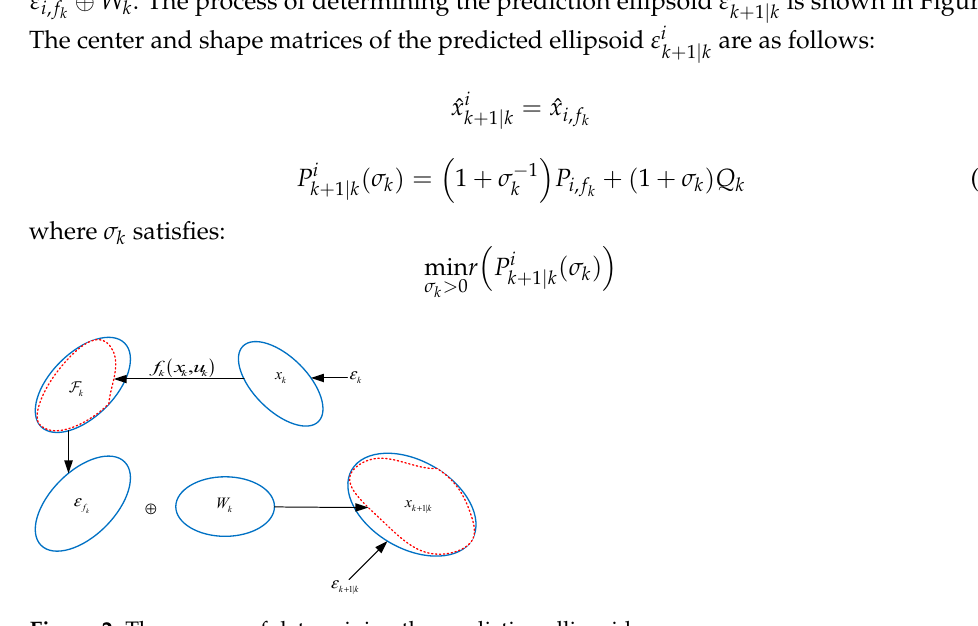
Figure 2. The process of determining the prediction ellipsoid ε i , k + 1 | k